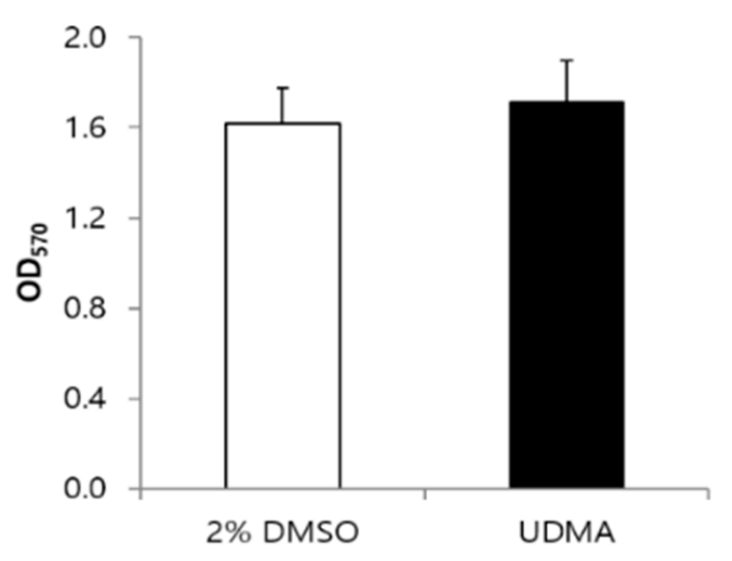
Figure 2. Cell viability of S. mutans UA159 grown in the presence and absence of UDMA at 16 h. UDMA was dissolved in DMSO, and cells grown in the absence of UDMA (2% DMSO) were used as the control. The data are expressed as mean ± standard deviation values.